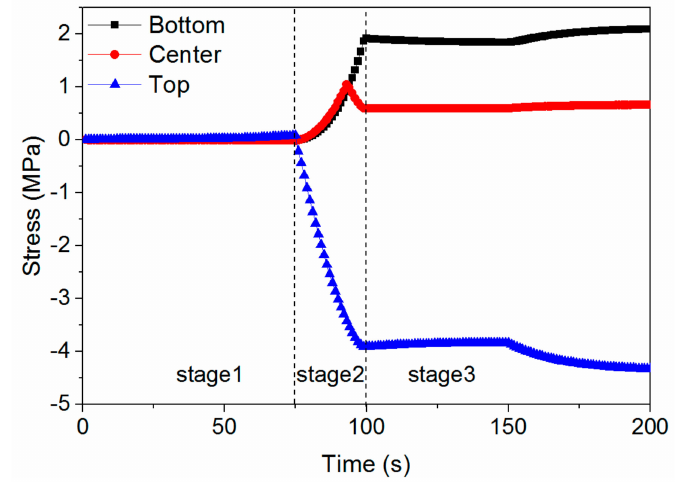
Figure 14. Stress evolution at different